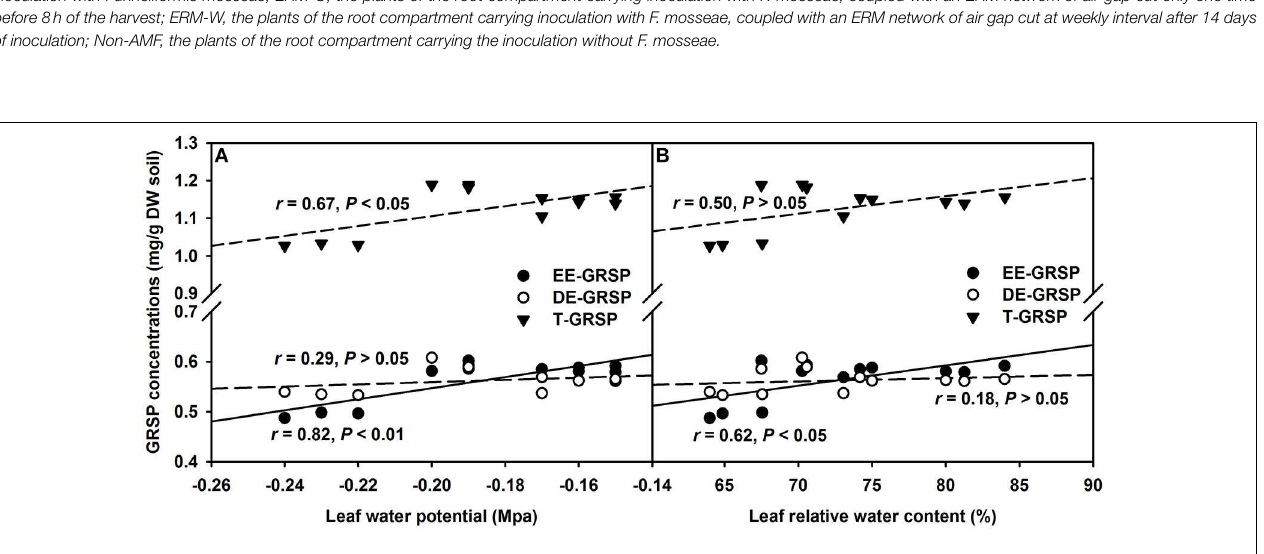
FIGURE 6 | Linear regression between leaf water potential (A) or leaf relative water content (B) and three glomalin-related soil protein (GRSP) fractions of root + hyphae compartment in trifoliate orange ( Poncirus trifoliata ) seedlings inoculated with or without Funneliformis mosseae ( n = 12 ).